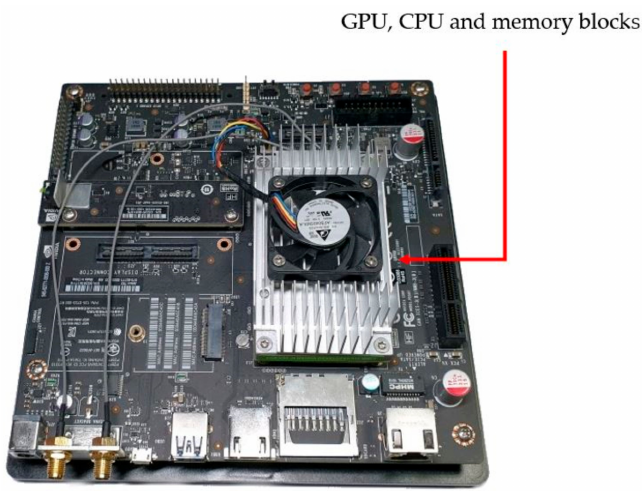
Figure 17. Jetson TX2 embedded system.